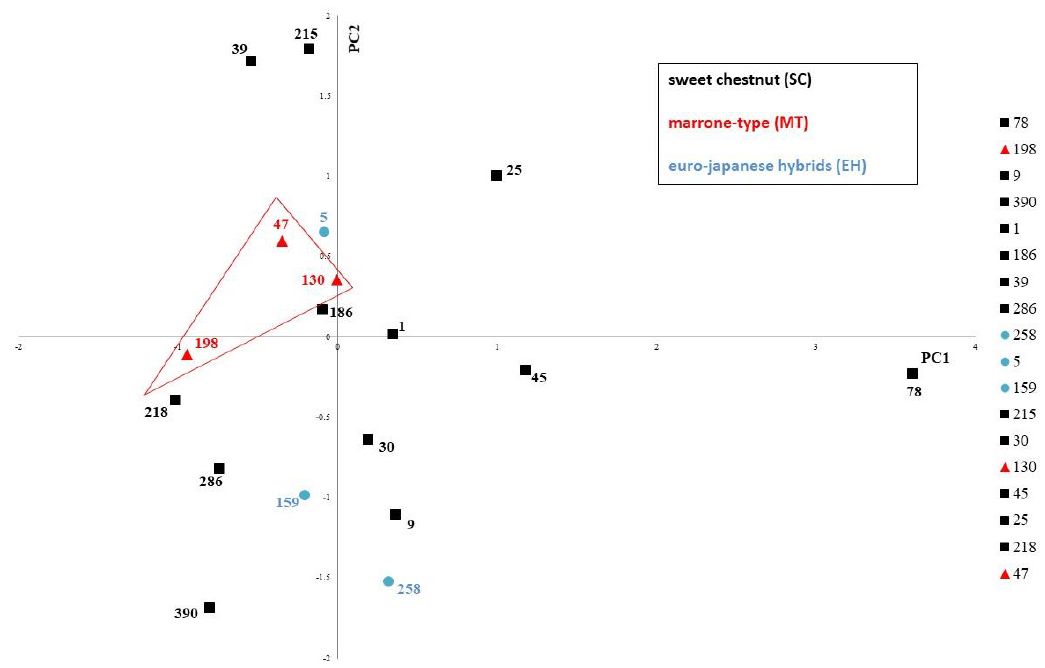
Figure 8. Principal component analysis (PCA) score plot of analysed chestnut cultivars. Mean values